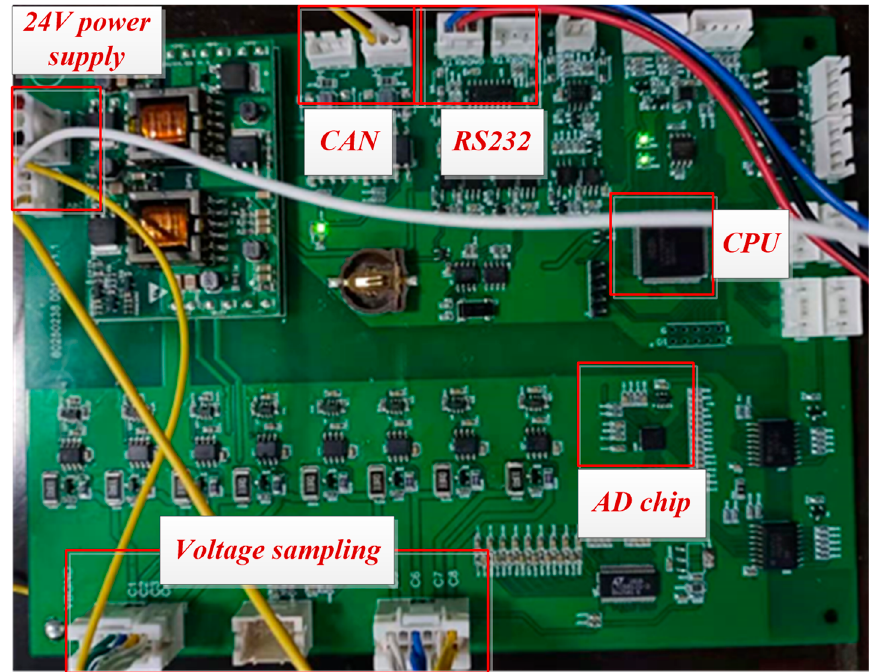
Figure 4. The hardware structure diagram of the slave control board.